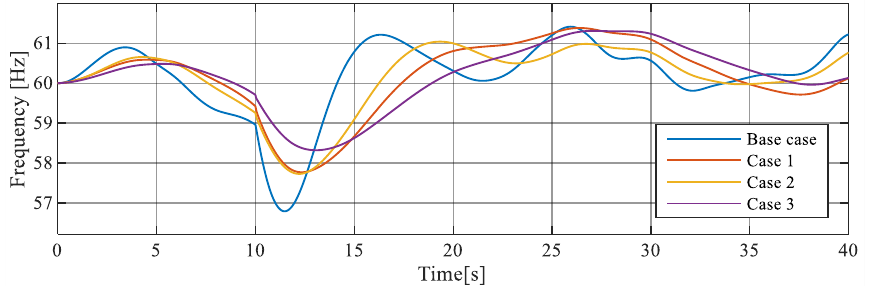
Figure 17. Frequency behavior during a sub-frequency contingence under actual wind speed conditions.